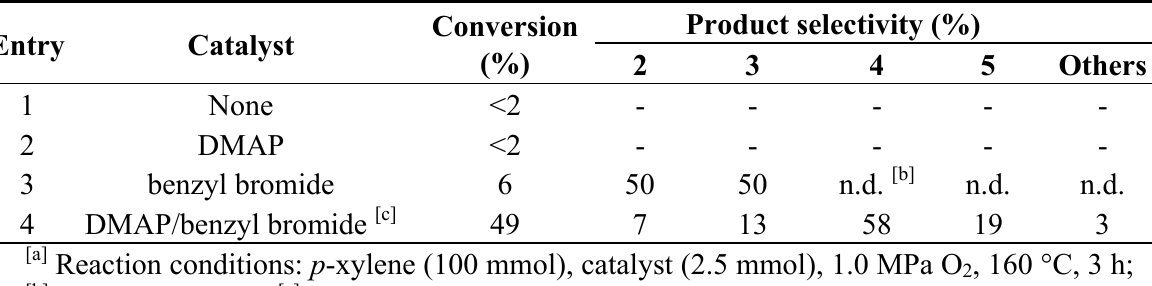
Table 1. Oxidation of p -xylene under solvent-free conditions [a] .